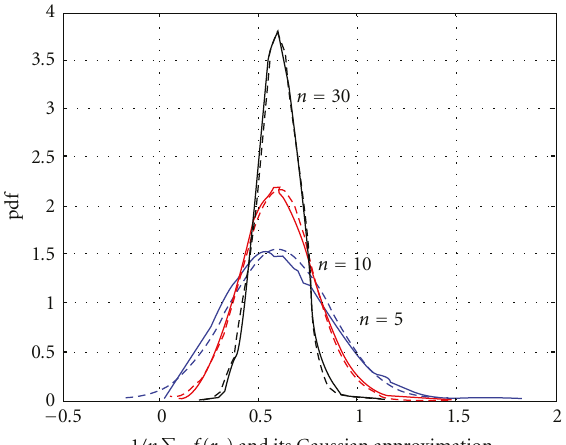
(cid:6) (solid line) u f u Figure 10: Capacity with 2% outage as a function of the path-loss exponent η , simulations (solid lines) and analysis (dotted lines) are